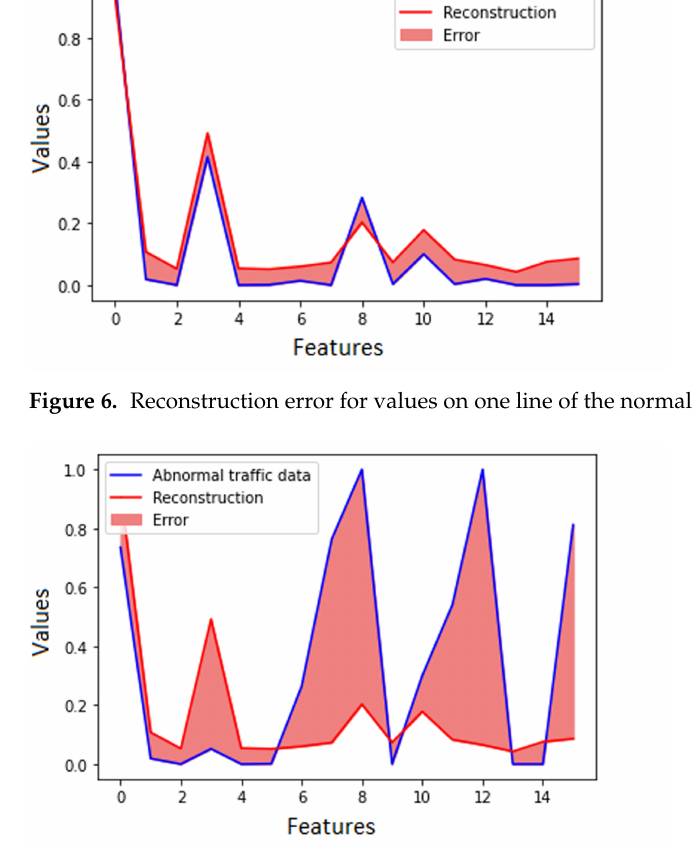
Figure 7. Reconstruction error for values on one line of the abnormal traffic data validation